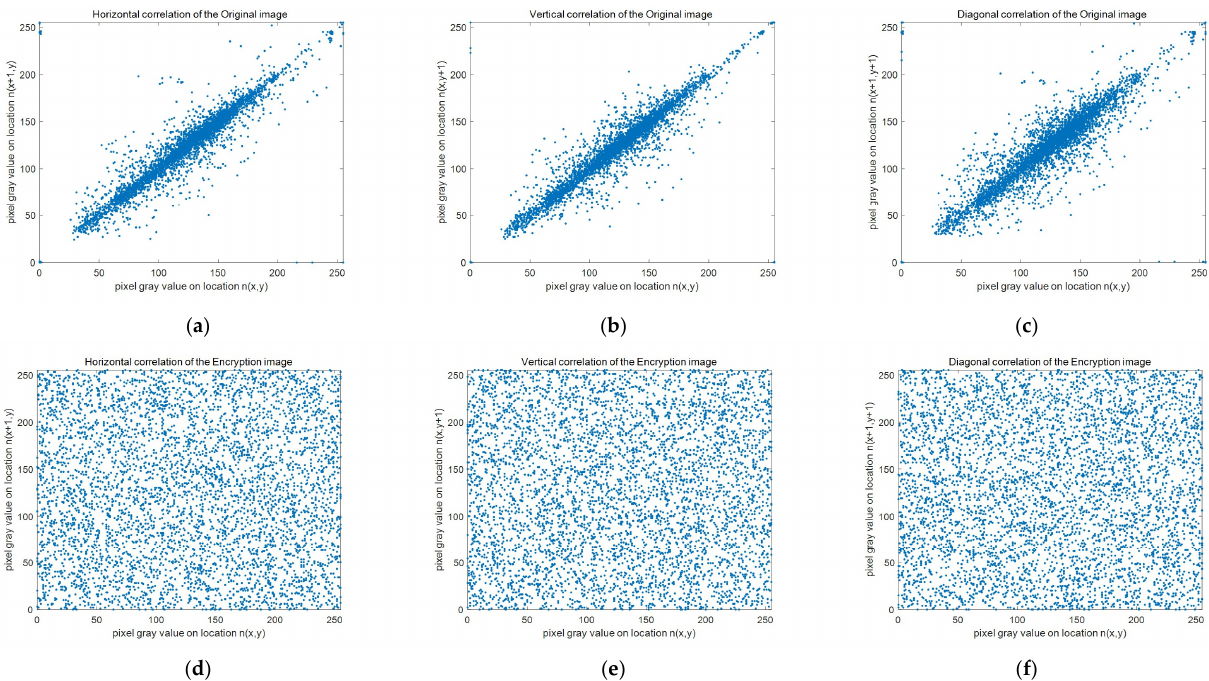
Figure 14. Adjacent pixel correlation of image 5.1.09: ( a – c ) original image; ( d – f ) encrypted image.